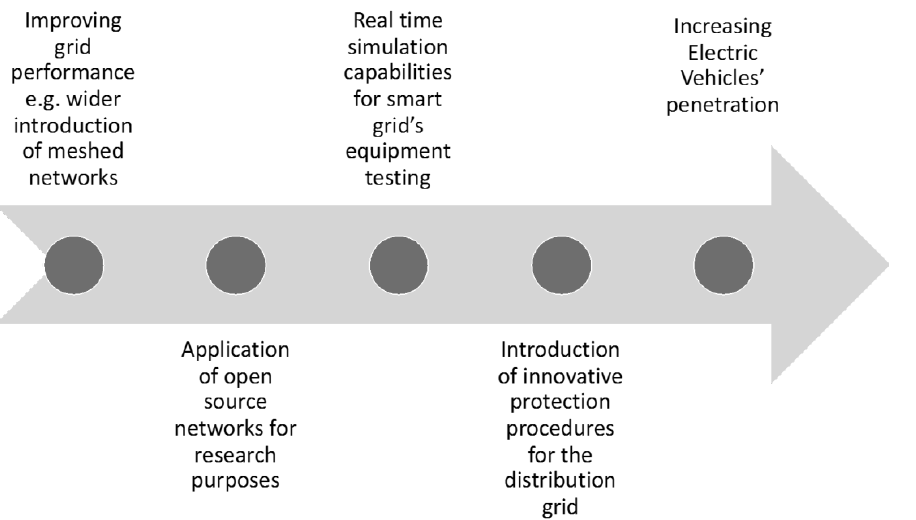
Figure 2. The expected evolvement towards solving the technical challenges for increasing electric vehicle penetration to the electricity network.